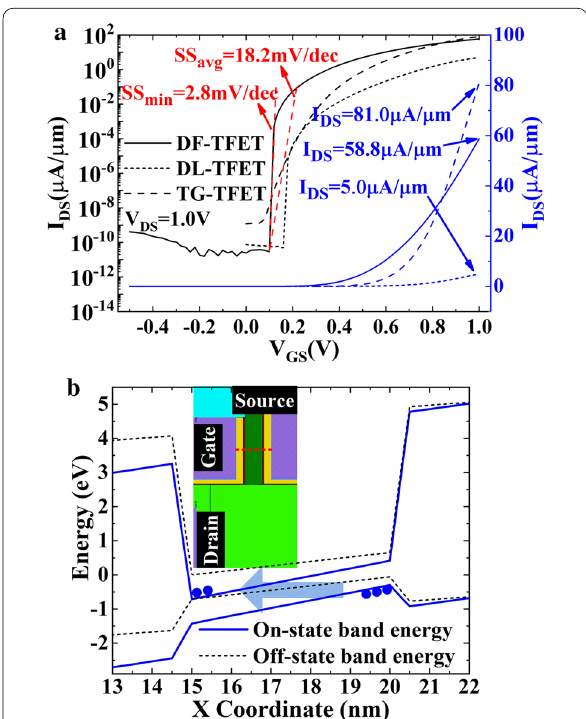
Fig. 3 a Transfer characteristics of DF-TFET, DL-TFET and TG-TFET. b Energy band condition of DF-TFET in different work conditions (the inset shows the cut line